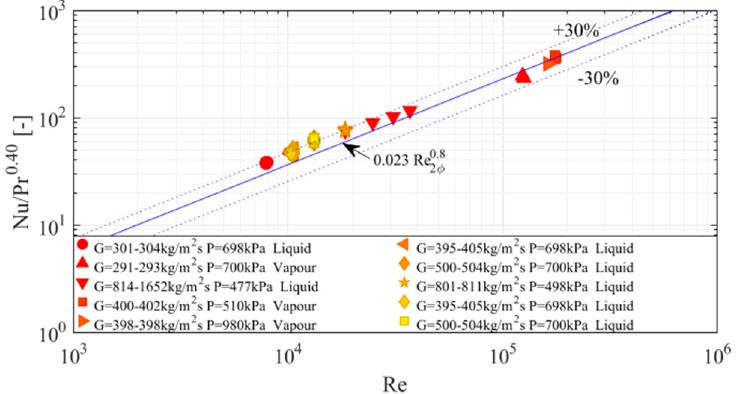
Figure 3. Single-phase heat transfer experimental results versus predictions by Dittus–Boelter. With two-phase flow boiling validation, a case of mass flux (G) of 200 kg/m 2 s, heat